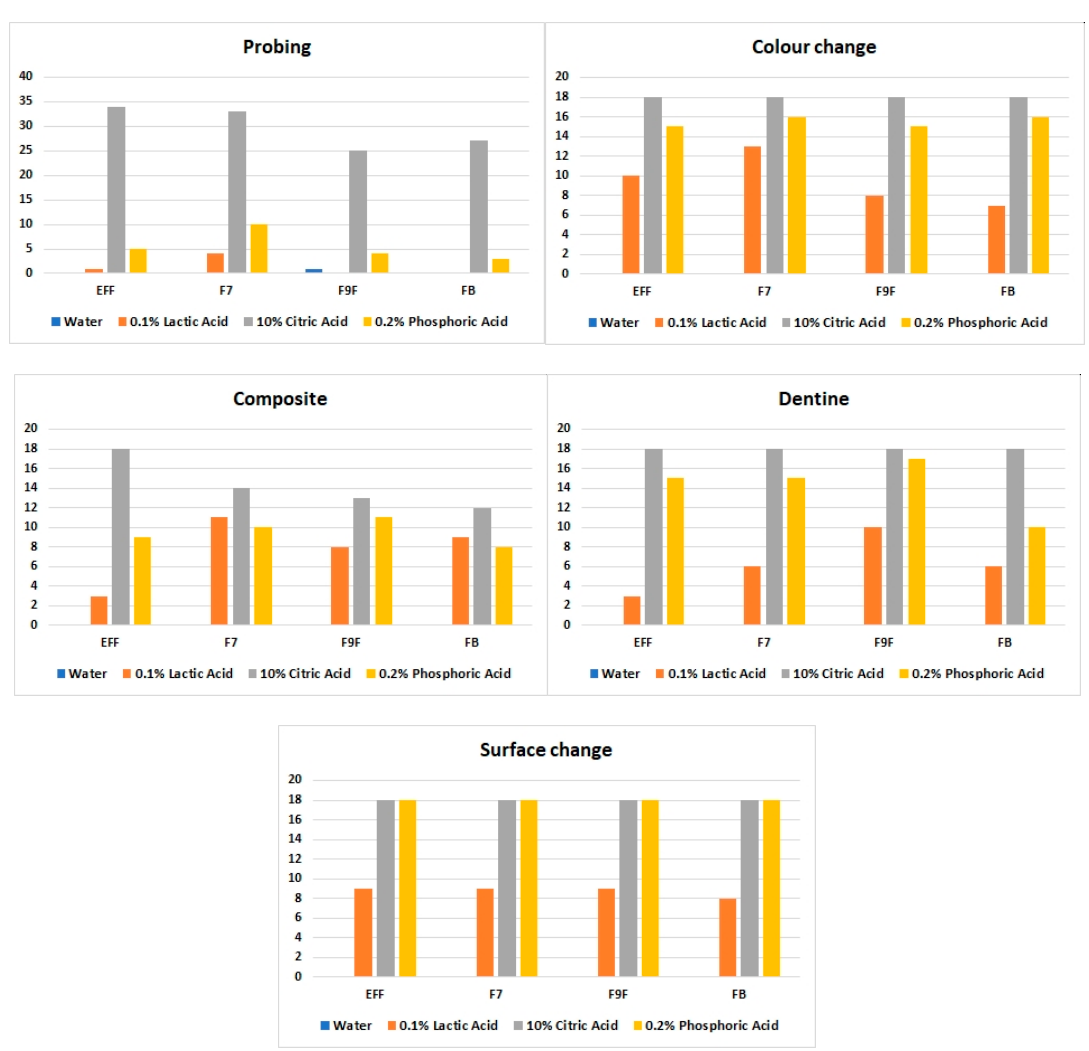
Figure 2. Cumulated assessor scores for qualitative assessments for open sandwich restorations on bovine teeth. From the top left, probing depth at the GIC surface, GIC color change, resin composite border changes, dentin border changes, and GIC surface irregularities. In each series the sequence of GIC materials is GC Equia ® Forte Fil (EFF), GC Fuji ® VII (F7), GC Fuji ® IX Fast (F9F), and GC Fuji ® Bulk (FB). Each sandwich restoration was assessed after seven days of media exposure ( n =